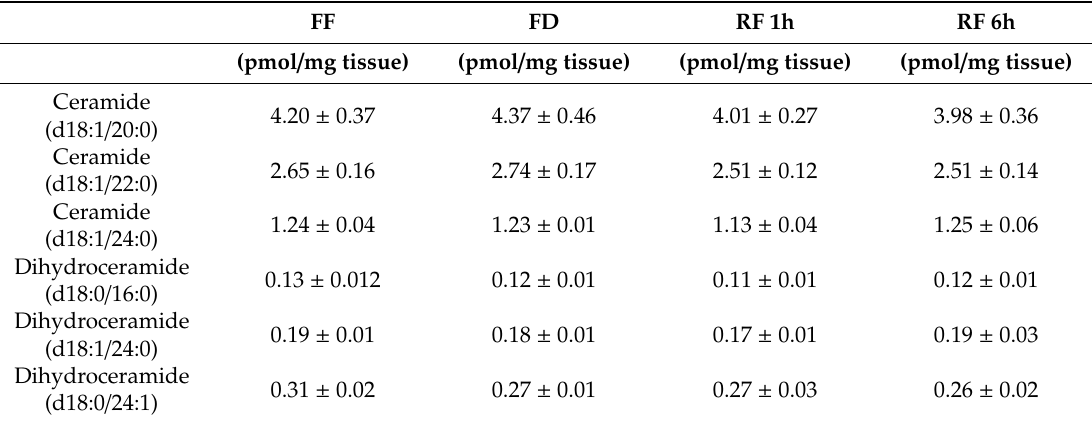
Free feeding (FF), 12 h food deprivation (FD), 1 h refeeding after FD (RF 1h) and 6 h refeeding after FD (RF 6h). Results are expressed as mean ± SEM ( n = 5 / feeding condition). * p < 0.05, ** p < 0.01, *** p < 0.001, one-way ANOVA followed by Tukey’s multiple comparison